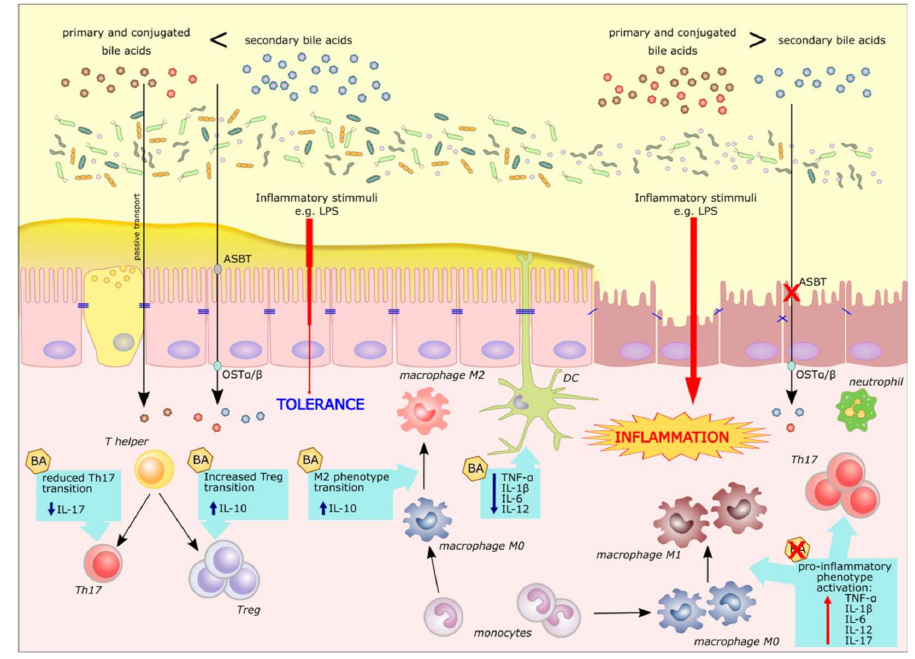
Figure 2. Regulatory role of bile acids in intestinal inflammation. Bile acids in the intestine are actively transported into lamina propria through sodium-dependent bile acid transporter (ASBT) and a complex of organic solute transporters α and β (OST α / β ) or by passive absorption. Bile acid signaling suppresses the pro-inflammatory phenotype of immune cells through reduced release of TNF- α , IL-1 β , IL-6 or IL-12. It also stimulates the production of an anti-inflammatory IL-10 cytokine and epithelial barrier renewal (not shown). Inflammatory bowel disease patients expe- rience reduced re-absorption of bile acids as well as disturbed intestinal bile acid metabolism by changed (reduced diversity) microbial community. A breach of the epithelial barrier may further exacerbate